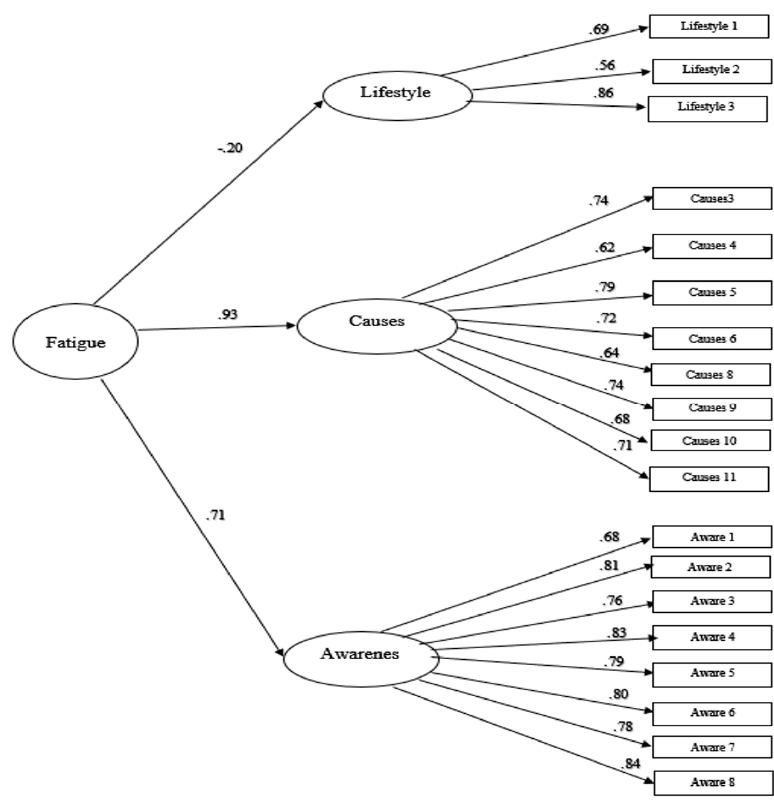
Figure 4. Full Conceptual Model of Fatigue Highlighting Strength of Relationships (Covariances Omitted for Clarity). Omitted for Clarity). (.xx means